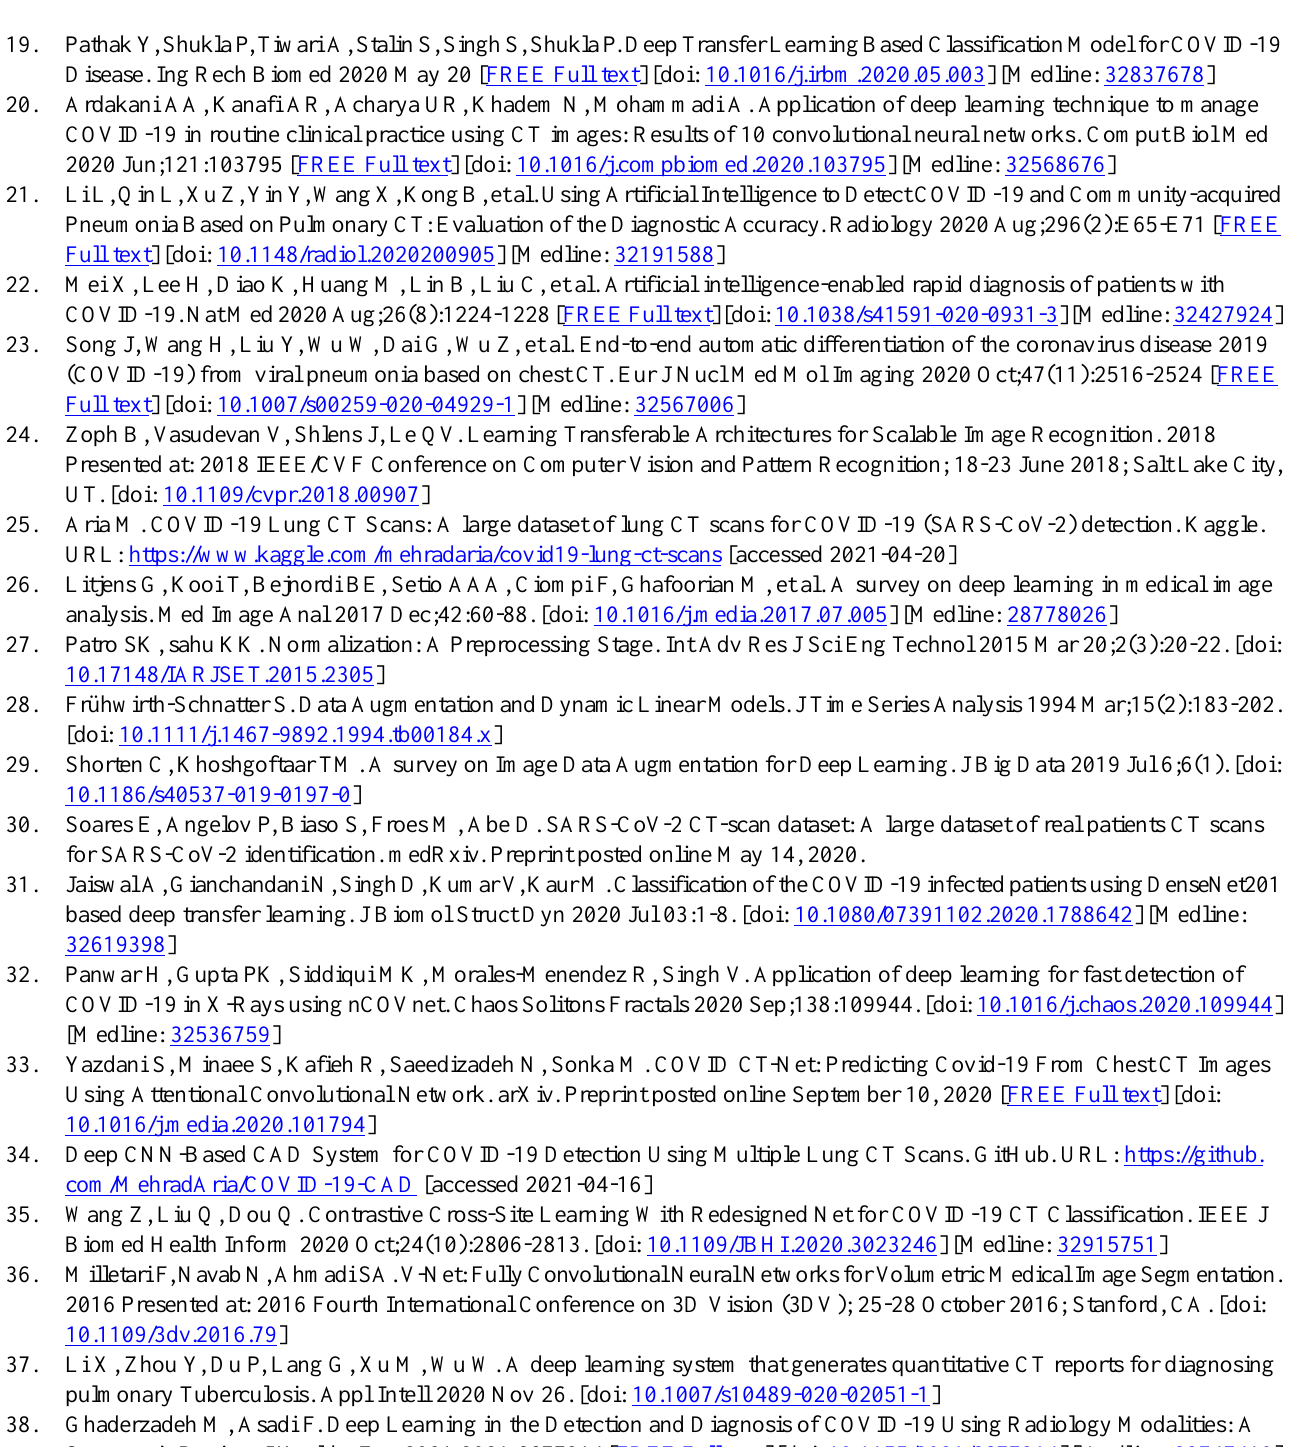
Abbreviations CNN: convolutional neural network CAD: computer-aided detection CT: computed tomography NASNet: neural search architecture network GGO: ground-glass opacities RT–PCR: reverse transcription–polymerase chain reaction WHO: World Health